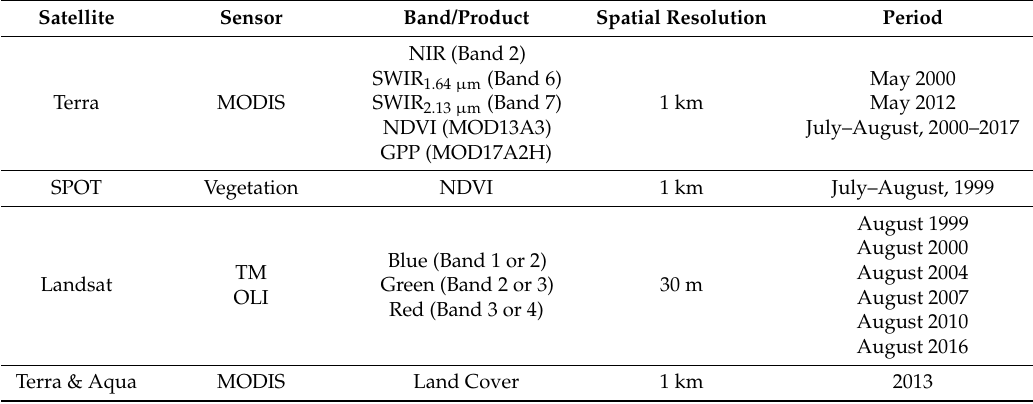
Table 1. Satellite data.